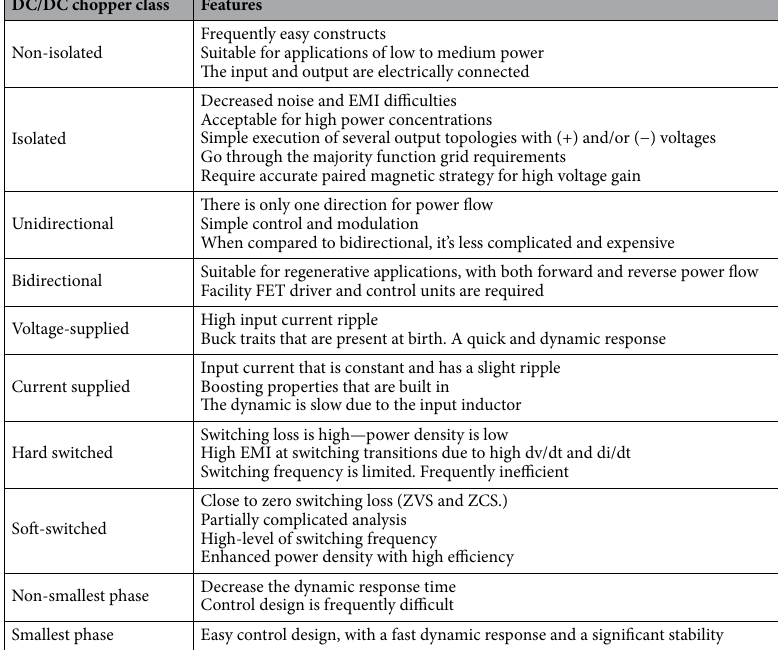
Table 1. DC/DC converter constructions and their features.